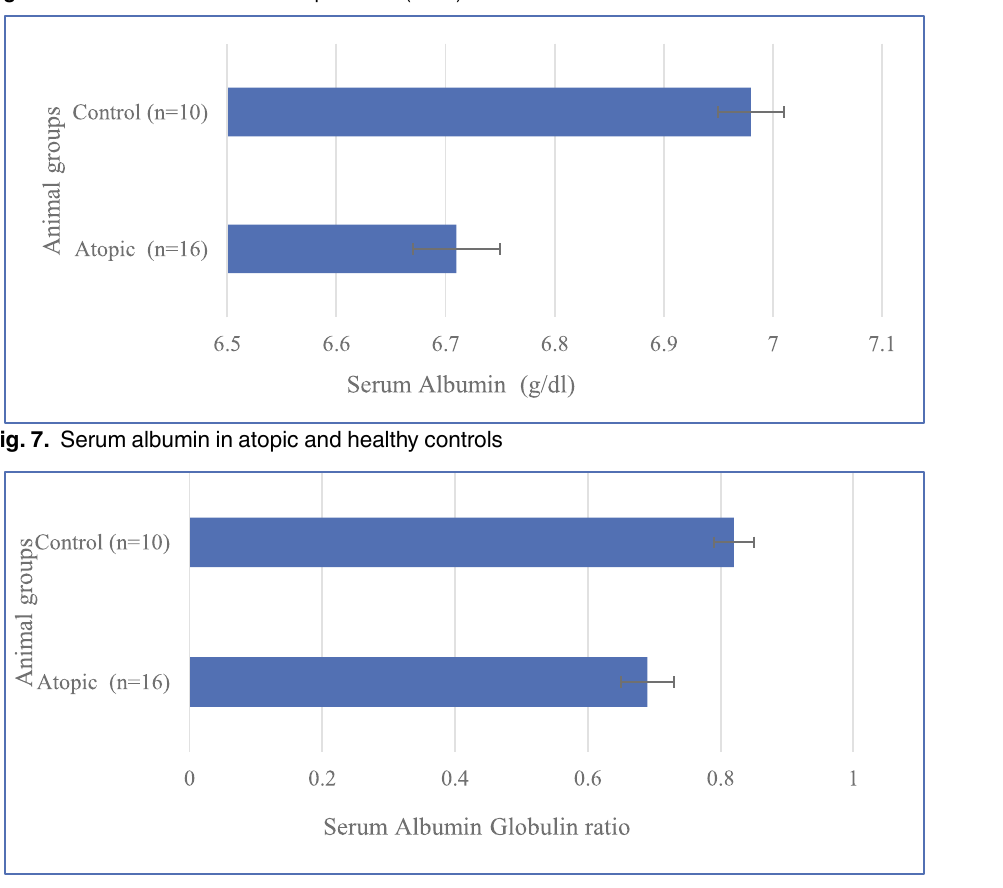
Fig.8. Serum albumin globulin ratio in atopic and healthy controls